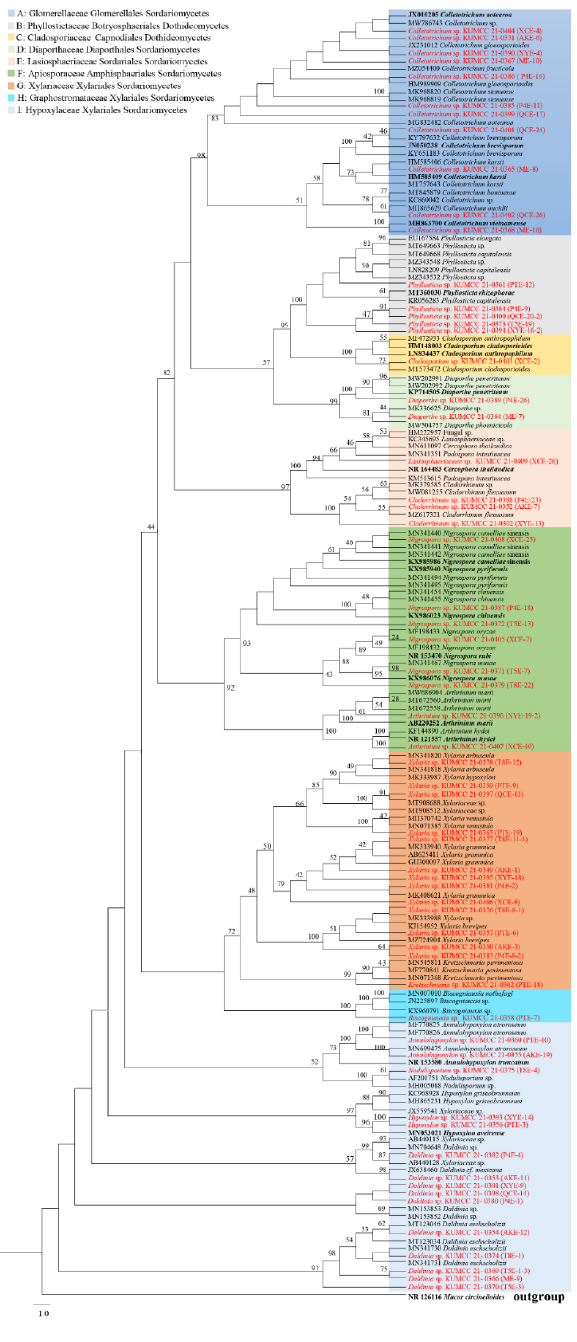
Figure 4. A maximum likelihood analysis showing the phylogenetic relationships of coffee fungal endophytes. The tree has a total of 167 fungal sequences, of which 61 fungal sequences came from the present study and 106 reference sequences of close relatives came from the GenBank. Mucor circinelloides (NR126116; Mucoraceae; Mucorale; Mucoromycetes) was used as the outgroup taxon. The bootstrap support values ( ≥ 50%) are indicated at the nodes. The bold font indicates the type species from the GenBank and data presented in the red font are the isolate code and culture number of the fungal endophytes obtained from the coffee leaves. Fungal isolates are further highlighted in different colors according to the family classification. Images on the right side of the phylogeny tree are the morphotypes of each